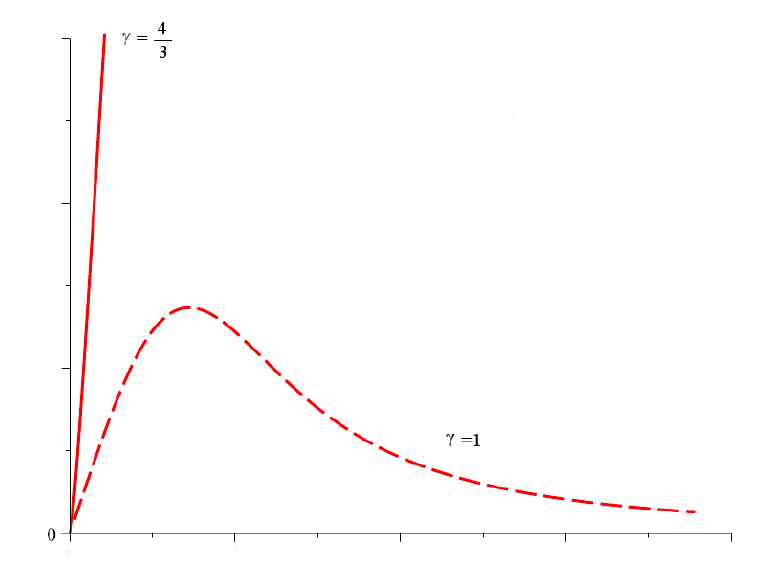
Figure 4. The areal radii of the apparent horizons versus the FLRW comoving time (both in units of ( ma ) 1/ ( 1 − β ) ) for ω = − 17/12. The dashed curve corresponds to dust ( γ = 1) and the solid curve 0 corresponds to both radiation ( γ = 4/3) and stiff matter ( γ = 2). For dust, a single apparent horizon expands to a maximum size and then shrinks.